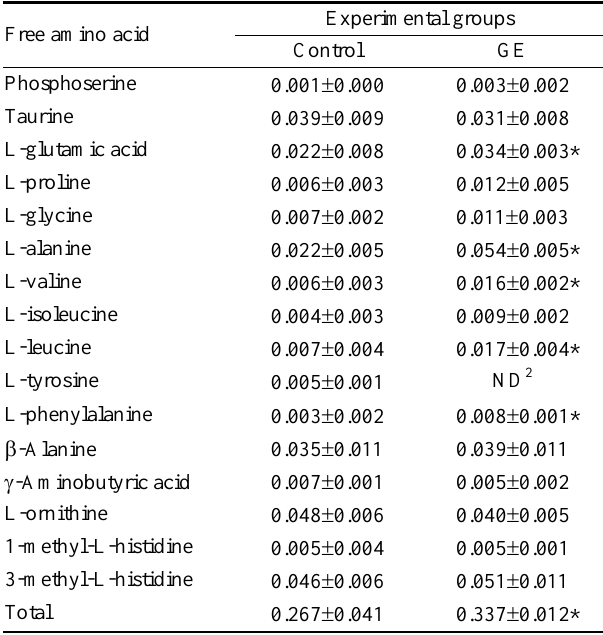
Table 3. Free amino acid composition (mg/100 mg, as-is basis) in muscle of juvenile sterlet sturgeon fed diets for 5 wks